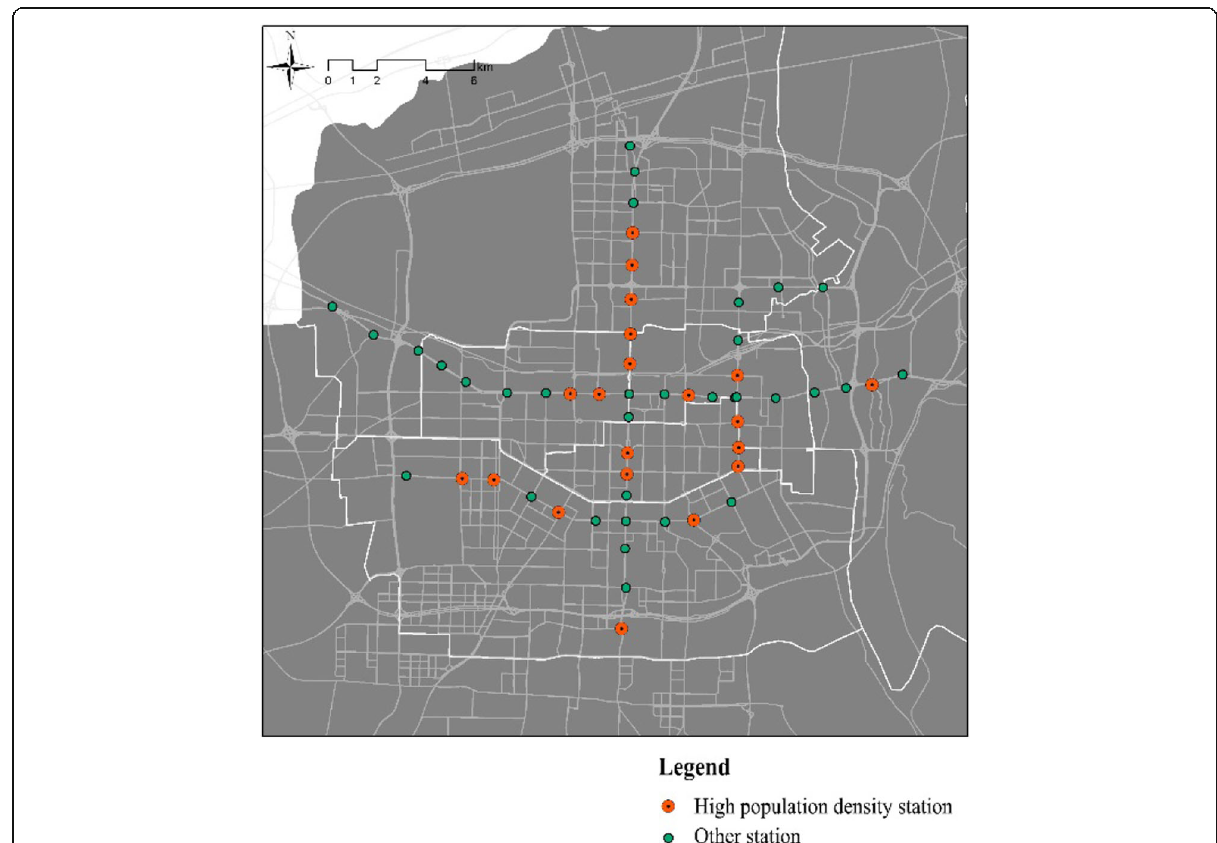
Fig. 2 Spatial distribution of high population density rail transit stations with high population